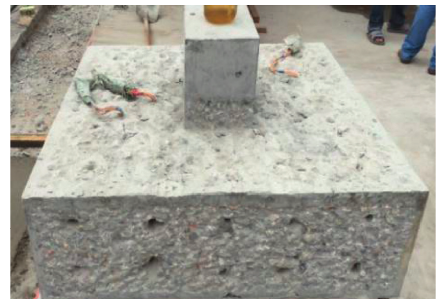
Figure 6: Planting bars diagram of pile foundation.